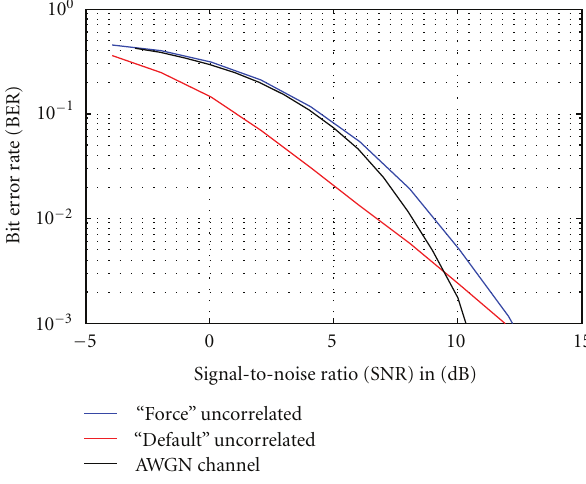
Figure 7: Example of subcarrier allocation in a “fully” correlated channel based on “All SINR” scheme.